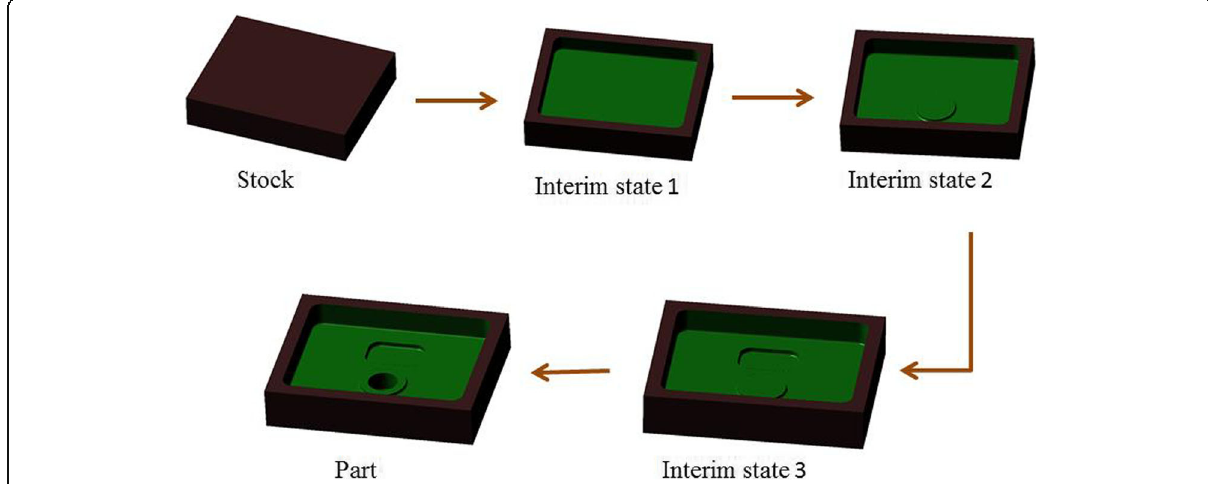
Fig. 4 Diagram of machining feature interim state construction